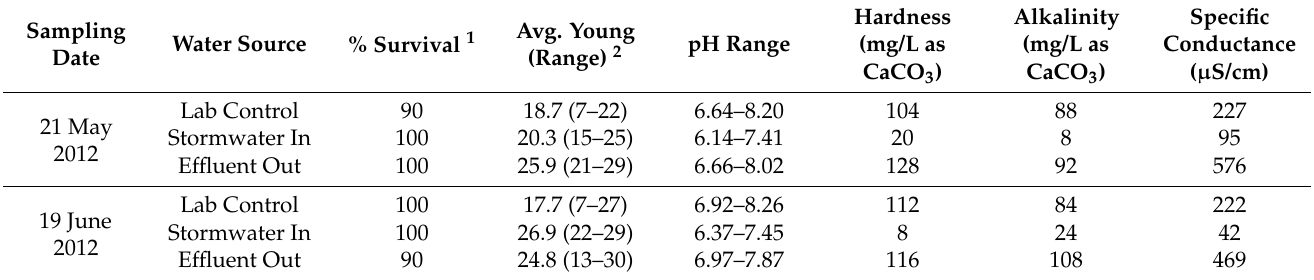
Table 3. Results of seven-day laboratory tests to assess chronic toxicity conducted with Ceriodaphnia dubia and stormwater collected at the inlet (untreated) and the outlet (treated) of the spent lime treatment cell on two